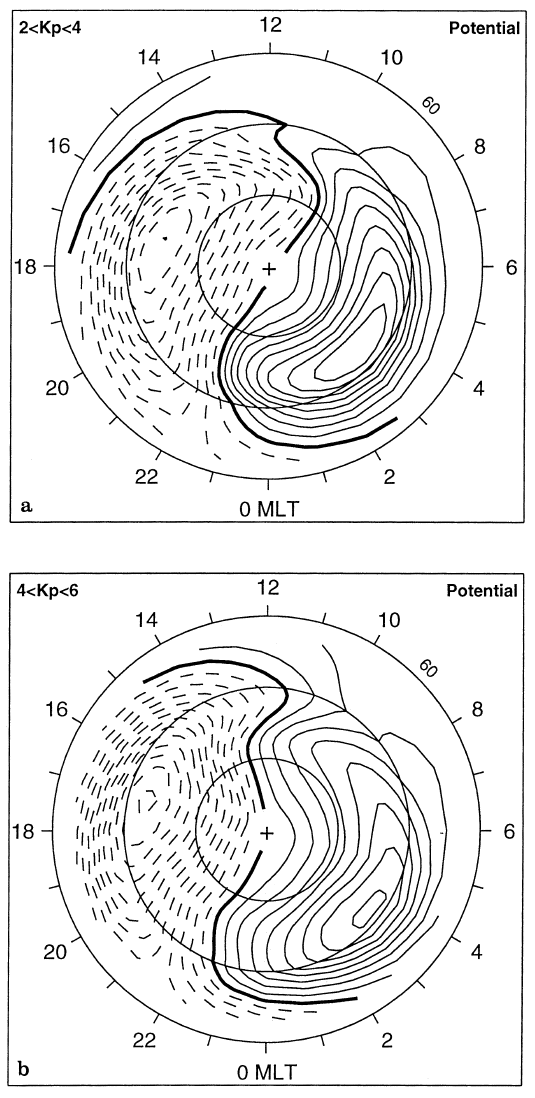
Fig. 3a,b. Equipotentials of the convection electric field represented in polar maps similar to Fig. 1. The contour interval is a 2 kV for 2 < Kp < 4, and b 3 kV for 4 < Kp < 6. The bold line corresponds to 0